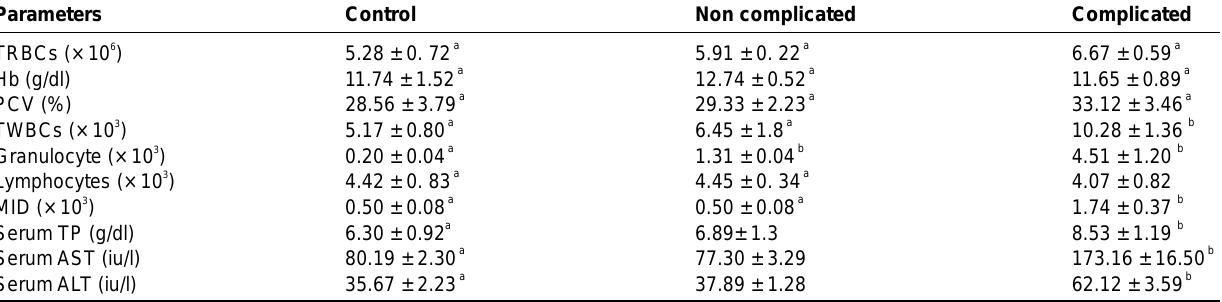
Table-2. Mean values (±SE) of haematological and biochemical indices in control, complicated and non complicated groups of SFBS in buffaloes